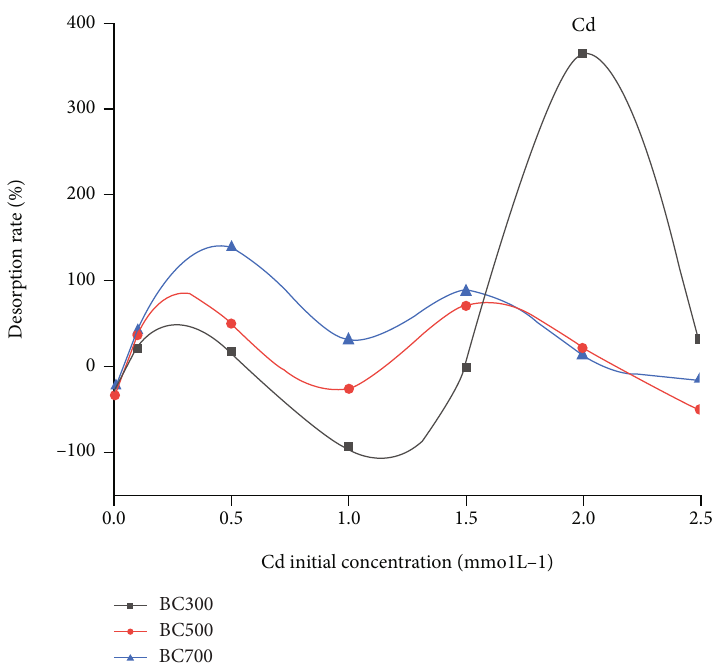
Figure 7: Desorption rate of Cd 2+ in straws with di ff erent concentrations of heavy metal